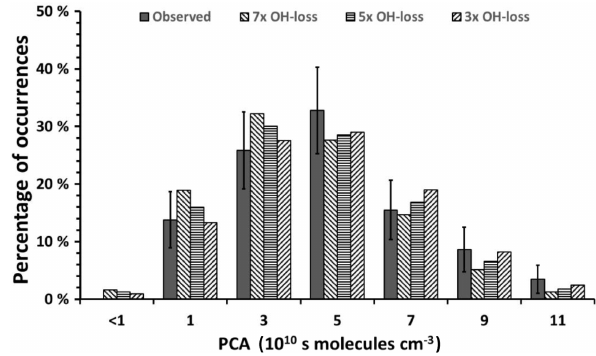
Figure 6. Comparison of the PCA distributions calculated for dif- ferent depositional loss rates of 4-nitrophenol. The depositional loss rates are given as multiples of the chemical loss rate of 4- nitrophenol due to reaction with OH radicals. For comparison, the PCA distributions determined from the 4-nitrophenol carbon iso- tope ratios reported by Saccon et al. (2015) are also shown. The error bars represent the statistical uncertainty resulting from the lim- ited number of